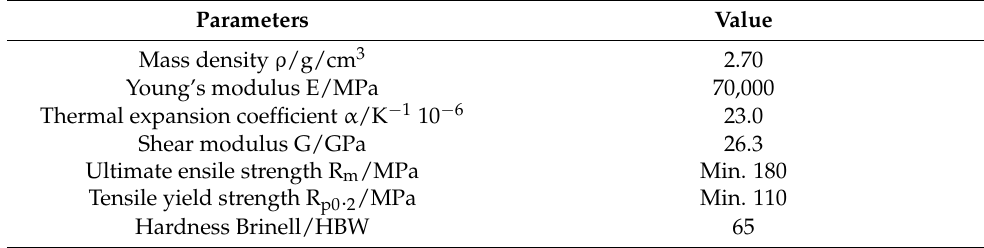
Table 1. Material properties of EN-AW 6061 T6.